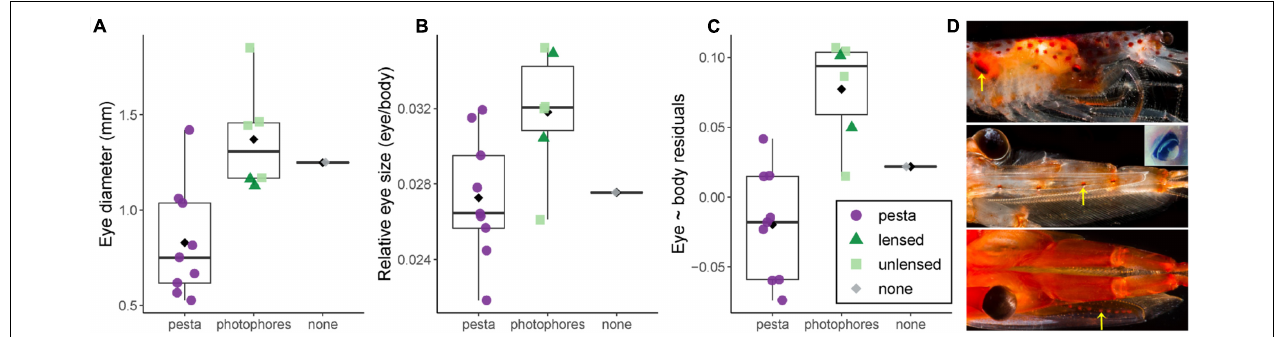
FIGURE 4 | Eye size variation by light organ type. Data are presented for -sergia (green) and -sergestes (purple) groups of sergestid shrimps across types of light organ: organs of Pesta (pesta; circle), lensed dermal photophores (photophores; triangle), unlensed dermal photophores (photophores; square), or those lacking light organs (diamond; none). For all plots, black diamonds indicate means, black bars indicate medians, boxes indicate interquartile ranges, and whiskers indicate minimum and maximum values. The Y-axes of each plot indicate (A) mean eye diameter, (B) mean eye diameter divided by mean body length, (C) residuals from the PGLS regression of sergestid eye-body evolutionary allometry at λ 1 , with negative and positive residuals indicating how small or large an eye is for a given sergestid compared to what is predicted by the model. (D) Representative images of sergestid light organs (yellow arrows), used with permission from the photographer, ©DantéFenolio. Top: organs of Pesta of Desosergestes henseni ; Center: lensed dermal photophores of Challengerosergia talismani (inset photo credit L. S.); Bottom: unlensed dermal photophores of Gardinerosergia splendens .